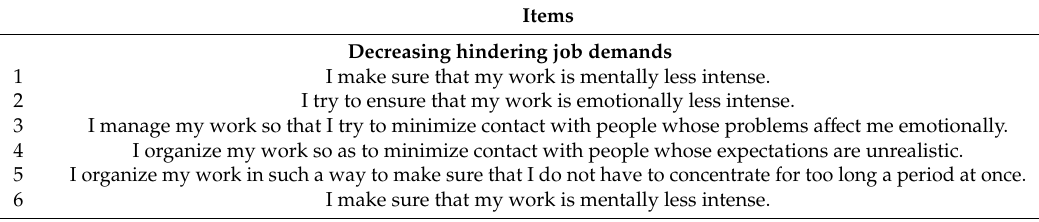
Table 3. Negative individual job crafting.